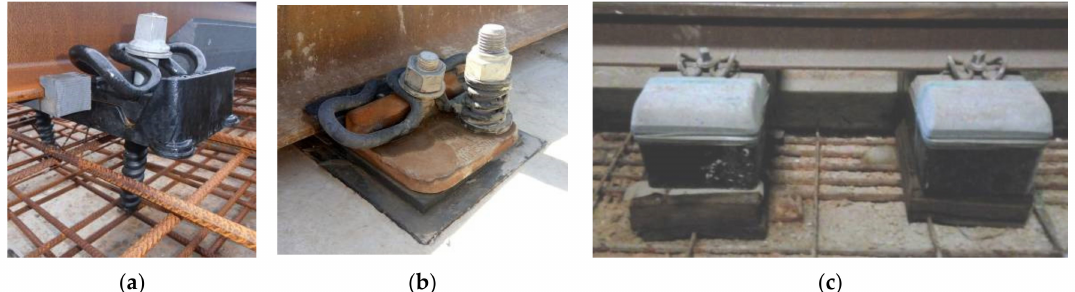
Figure 3. Details of ( a ) a fastener booth and insulating block, ( b ) insulating pads and ( c ) the floating blocks